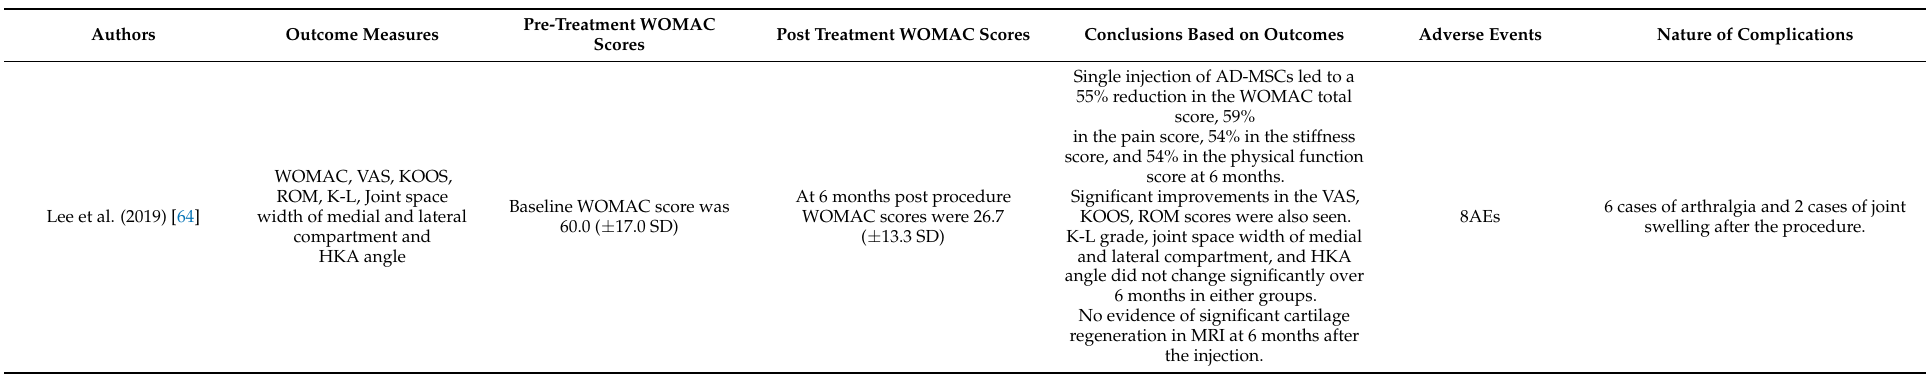
Table 5. Outcomes and complications, n =